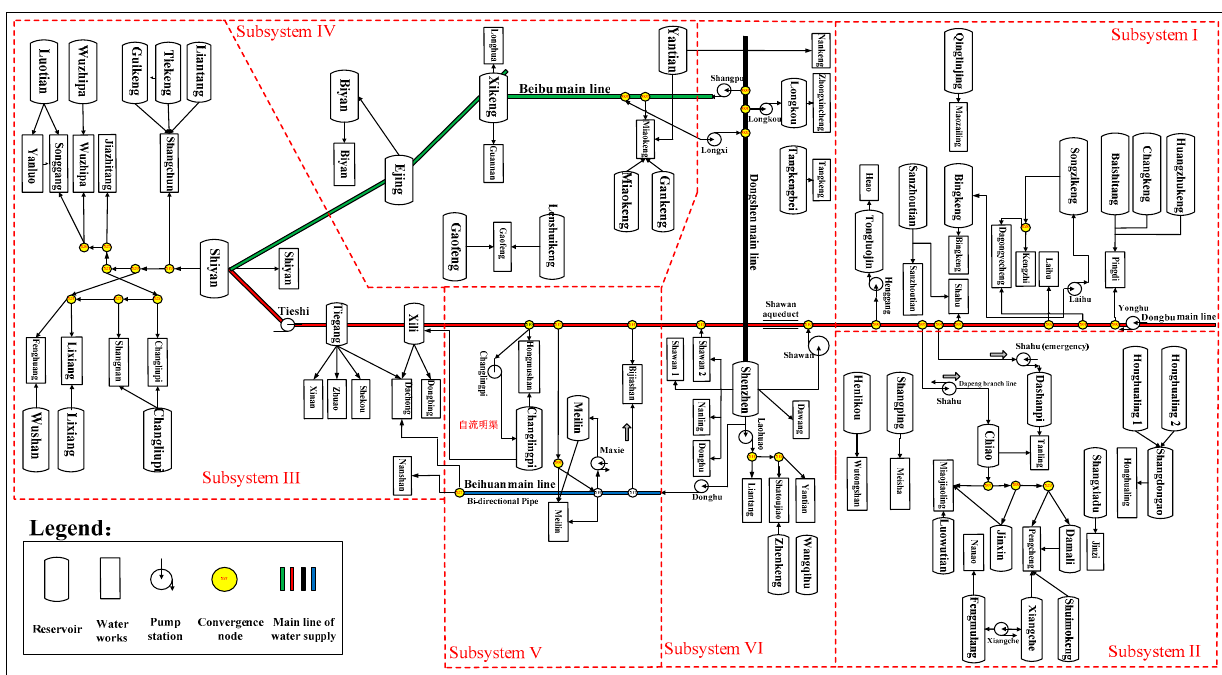
Figure 2. Generalization chart of the water supply system in Shenzhen.